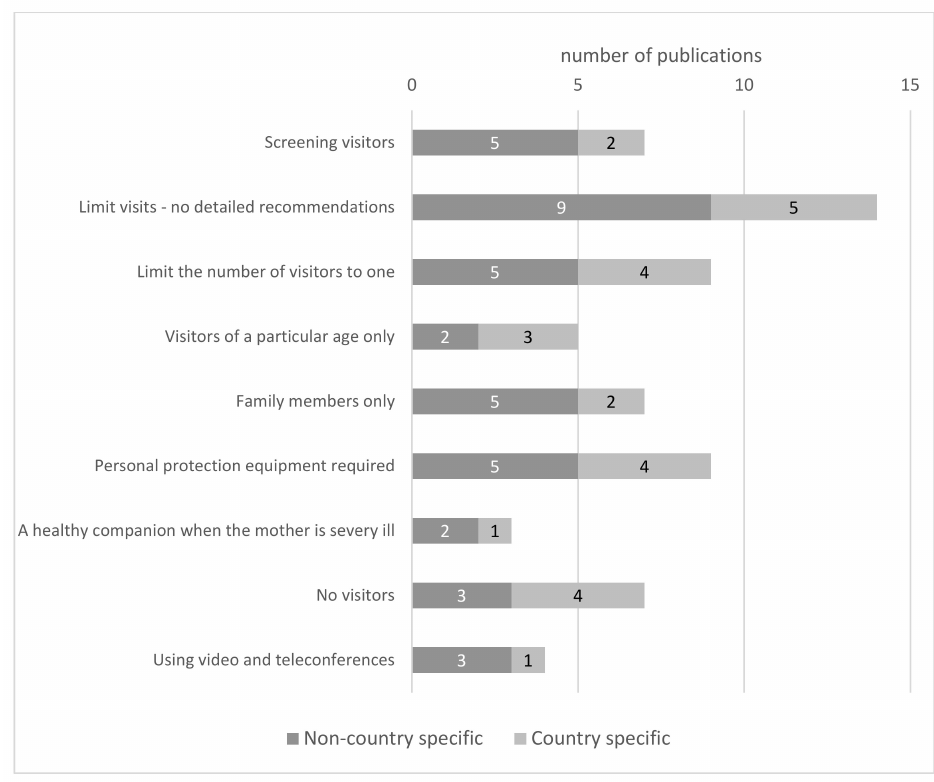
Figure 3. Recommendations concerning visitor policies on maternity wards for mothers with con- firmed and/or suspected